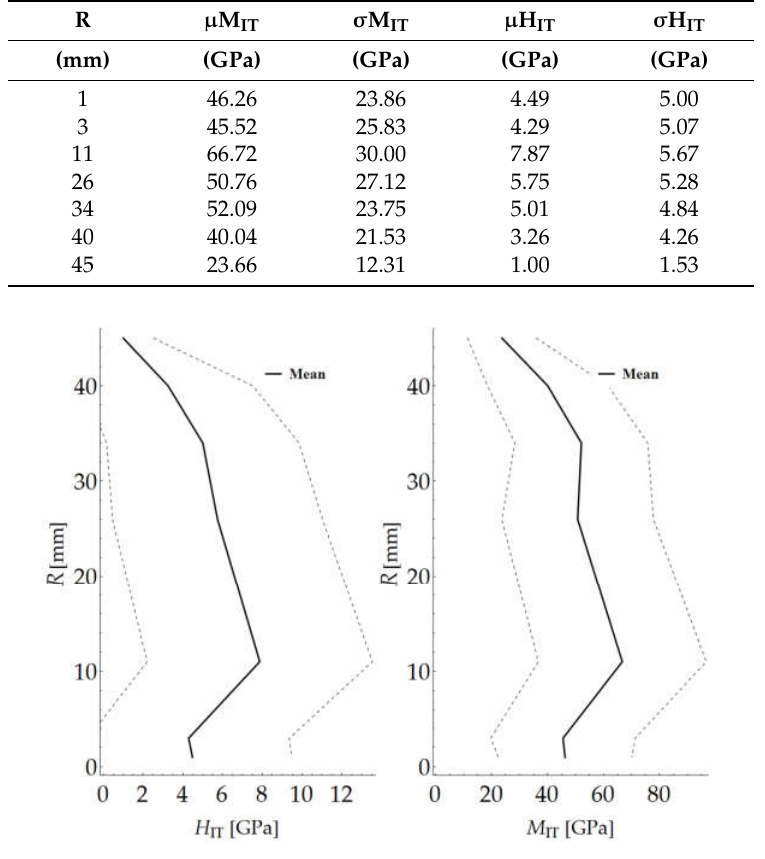
Figure 23. Variation in hardness HIT and indentation modulus MIT across wall of cross section.